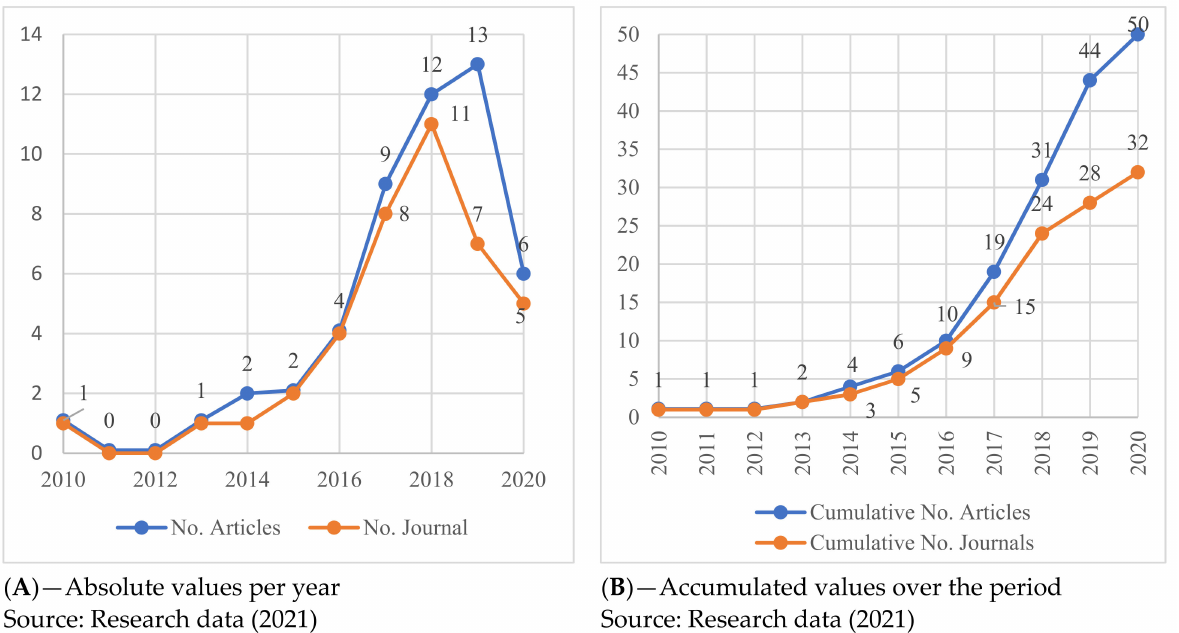
Figure 2. Chronological profile of publications identified as most relevant by the Methodi Ordinatio, represented in absolute ( A ) and cumulative ( B ) values. Note: 2B the journals are counted only the first time it